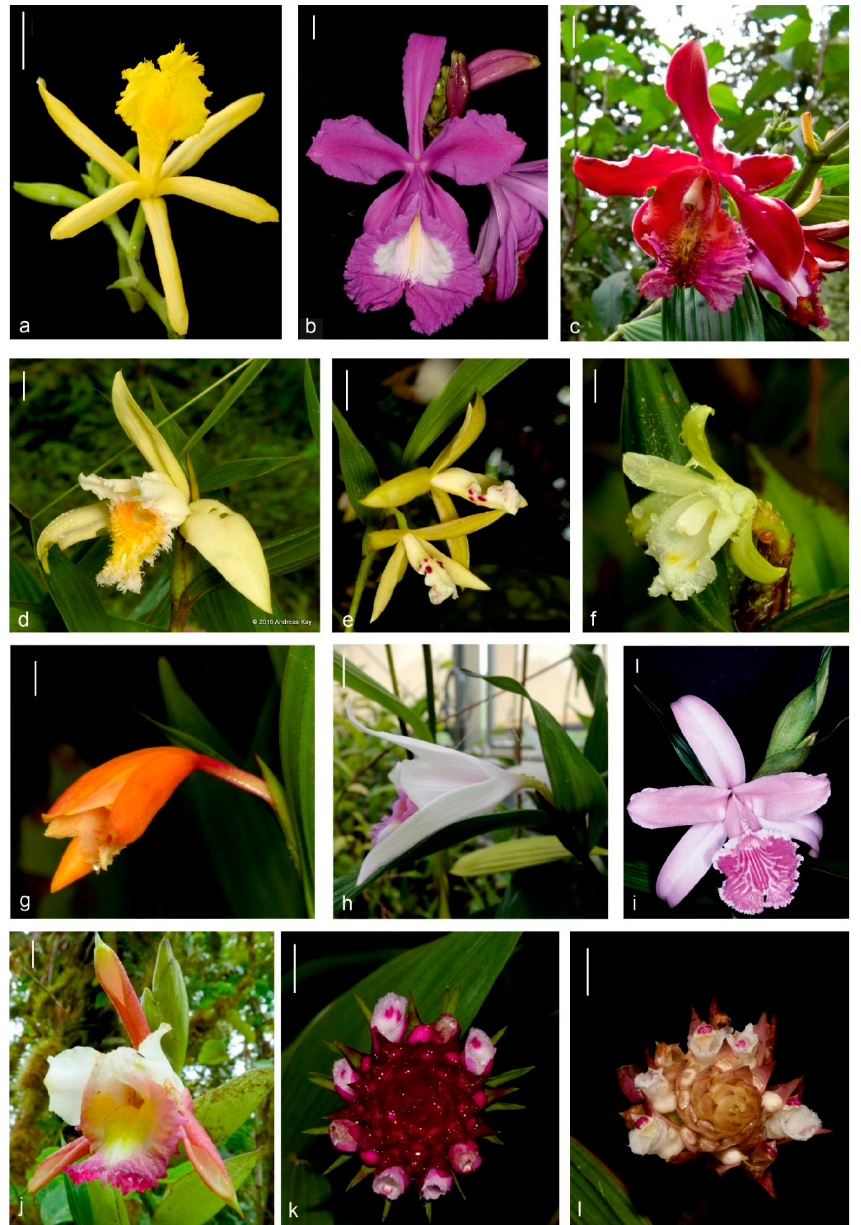
Figure 1. Diversity in Brasolia , Sobralia and Elleanthus flowers. ( a ) B. flava (Eric Hunt); ( b ) B. portillae (Lourens Grobler); ( c ) B. dichotoma (Marta Kolanowska); ( d ) S. fimbriata (Andreas Kay); ( e ) S. lancea (Andreas Kay); ( f ) S. bimaculata (Andreas Kay); ( g ) S. crocea (Andreas Kay); ( h ) S. decora (Przemyslaw Baranow); ( i ) S. rosea (K-Eric Hunt); ( j ) S. gloriosa (Andreas Kay); ( k ) E. brasiliensis (Ana Paula Moraes); ( l ) E. crinipes (Carlos Nunes). Scale bars = 10 mm.